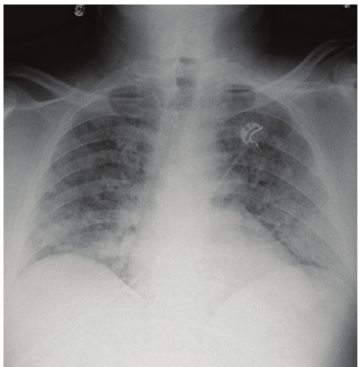
Figure 2: Chest X-ray from hospital day 3 showing worsening bibasilar